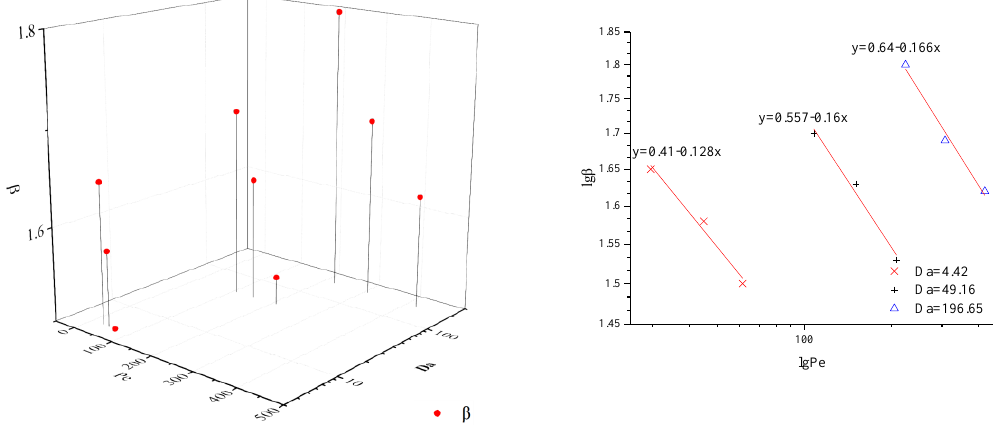
Figure 4. β under different value of Pe and Da.